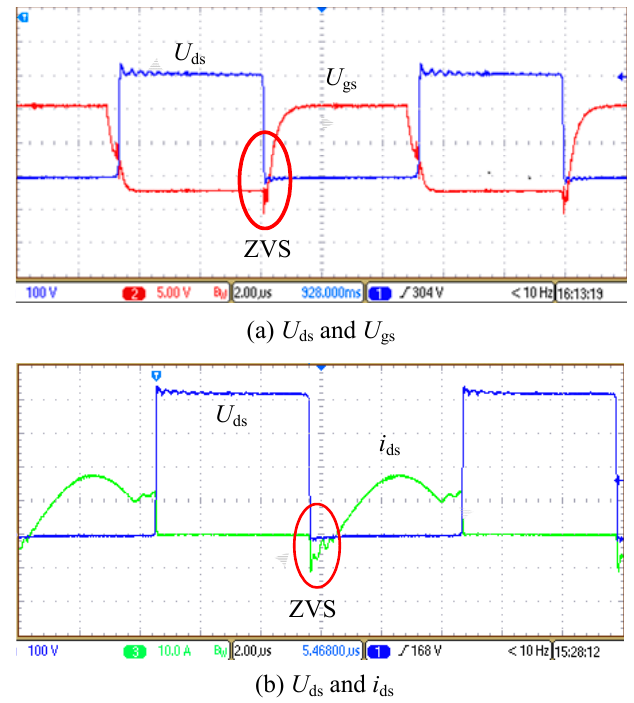
Figure 3. Features of MOSFET to achieve zero voltage turn-on. ZVS, zero voltage switching.